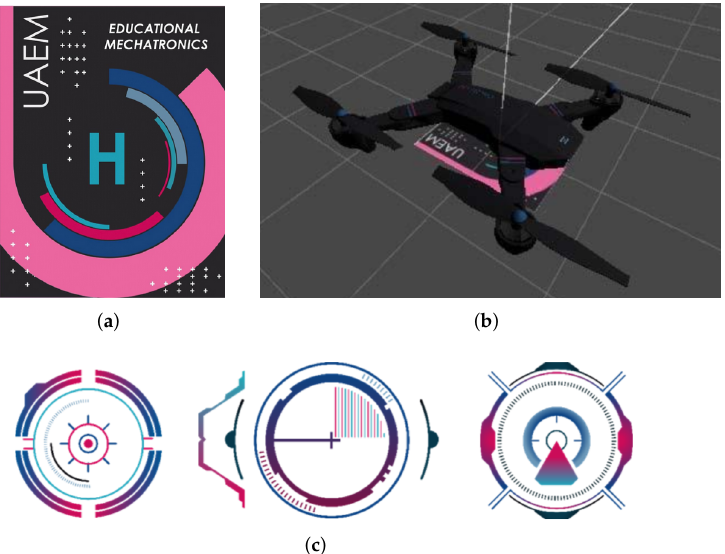
Figure 17. MOCAP measurements of real flight with drone following the second movement. ( a ) Target to activate the augmented reality model. ( b ) Drone in the Unity engine. ( c ) Command buttons in the AR application.